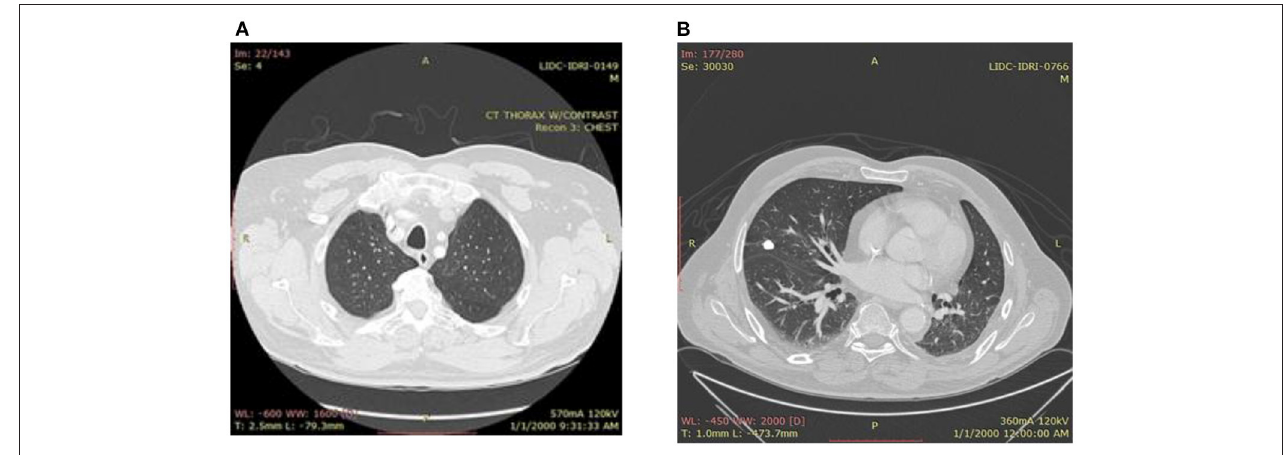
FIGURE 1 | (A) Benign lung image. (B) Malignant lung.